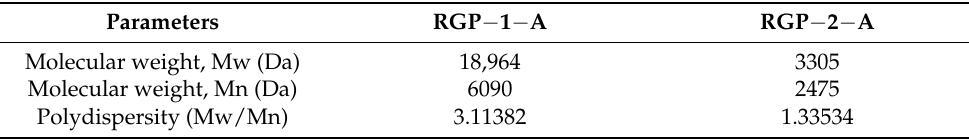
Table 1. Molecular weight of different polysaccharides.